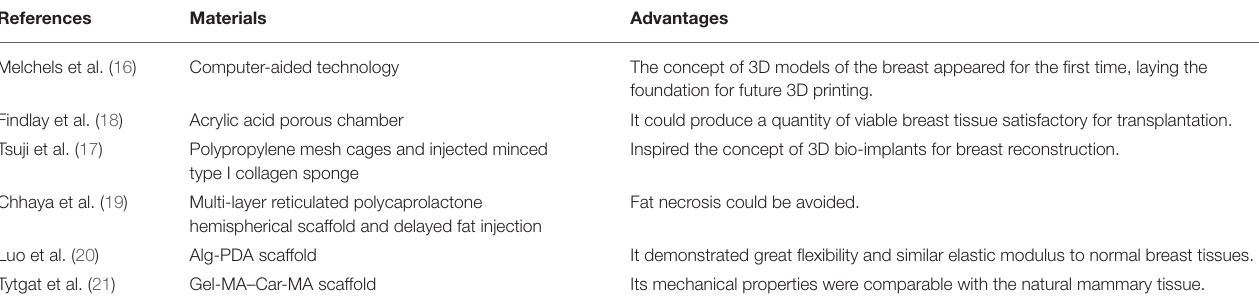
TABLE 1 | Summary of tissue engineering materials in breast